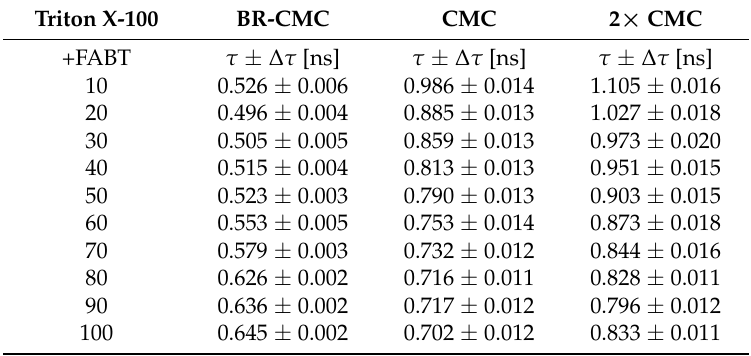
Table 1. Fluorescence lifetimes in BR-CMC, CMC and 2 × CMC